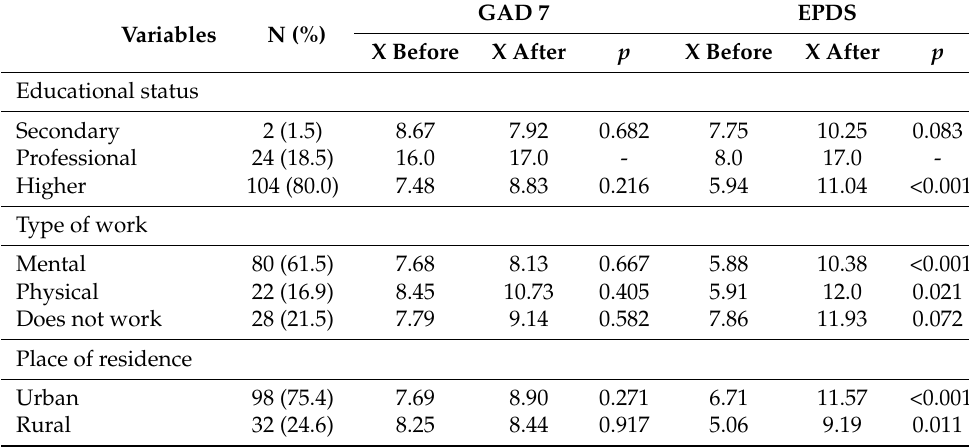
Table 4. The influence of selected factors on a change in the level of prenatal and postnatal anxiety and depression in